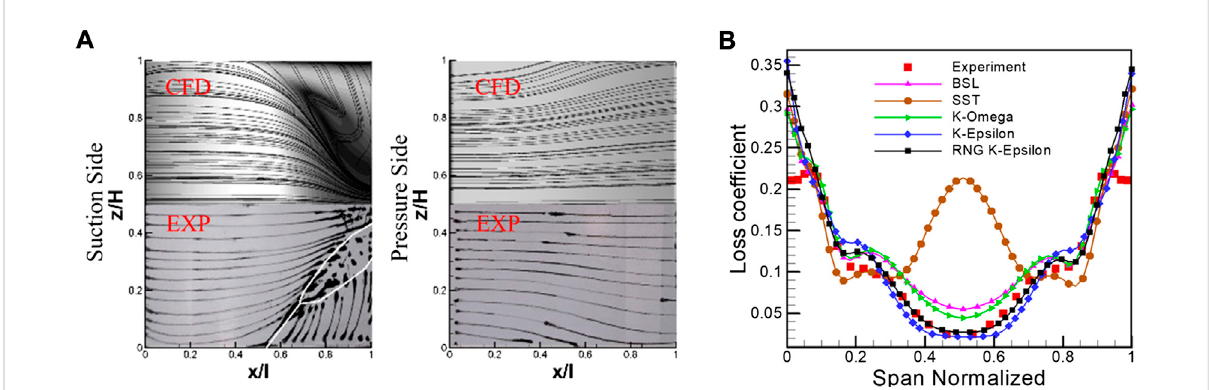
FIGURE 3 Validation ofthe 3-Dsimulationmodel. (A) Limiting stream lines ofCFD and experimentalresults; (B) thespanwisedistribution of totalpressure loss coef fi cient at